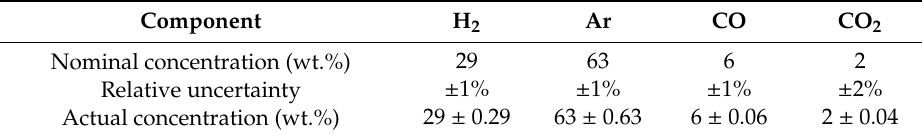
Table 6. Chemical composition (wt.%) of the calibration gas. Component H